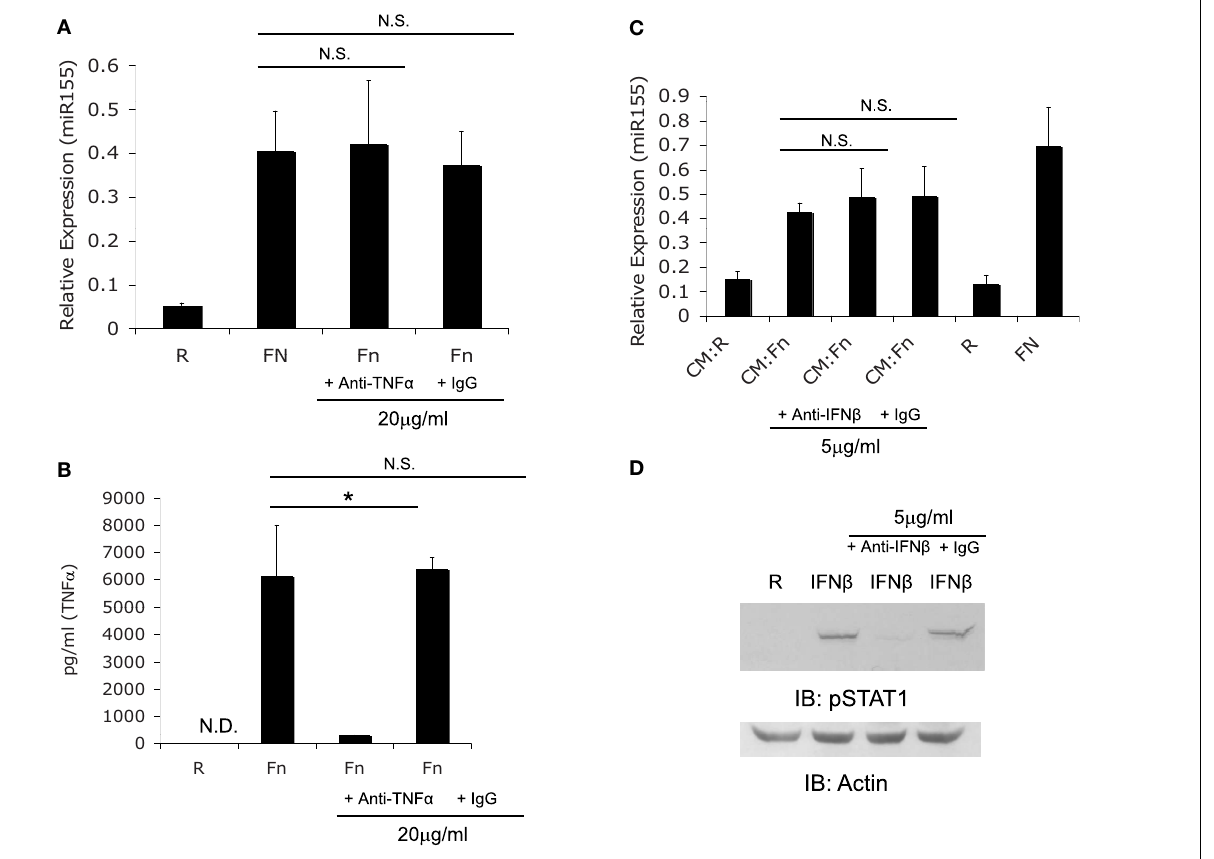
FIGURE 3 | F. novicida induction miR-155 expression is not mediated by TNF α or IFN β . (A) PBM were treated withTNF α neutralizing antibody or isotype control antibody, then infected with F.n. at an MOI of 50 for 6h. RNA was collected and assayed for miR-155 expression. (B) The media from the samples in (A) was assayed for humanTNF α by ELISA. (C) Conditioned media (CM) was obtained as in Figures 2B . Conditioned media from monocytes uninfected (CM:R) or infected (CM:Fn) with F.n. at an MOI of 50 was sterile filtered and incubated with neutralizing antibody or isotype control antibody at